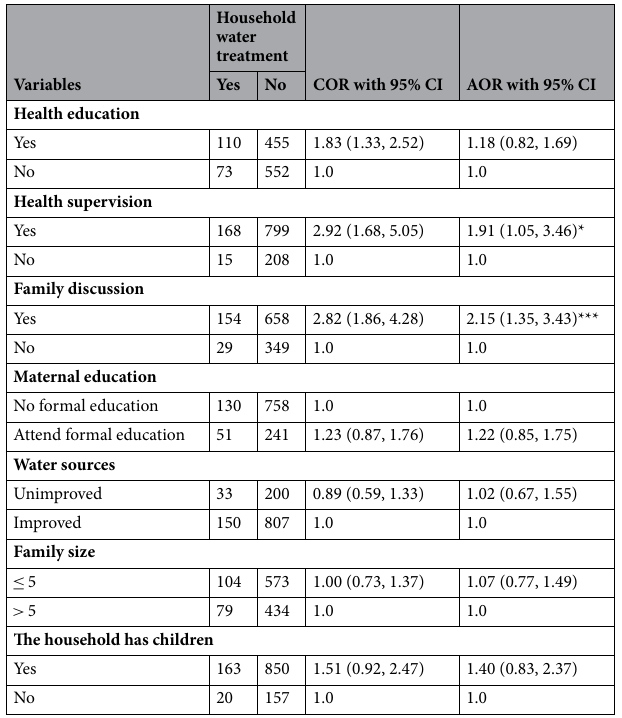
Table 6. Factors associated with household water treatment practice among households (n = 1190) in a rural setting of northwest Ethiopia, May 2016. AOR adjusted odds ratio, CI confidence interval, COR crude odds ratio. *Statistically significant at p < 0.05, *** statistically significant at p < 0.001, Hosmer and Lemeshow test =